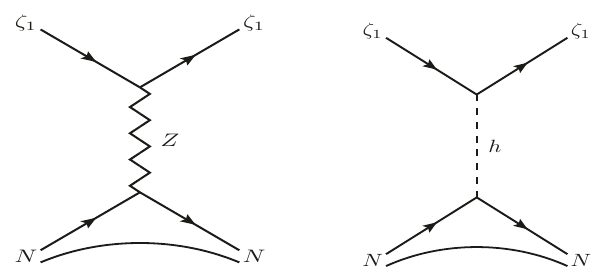
Figure 3 . Feynman diagrams contributing to the spin independent direct search of the